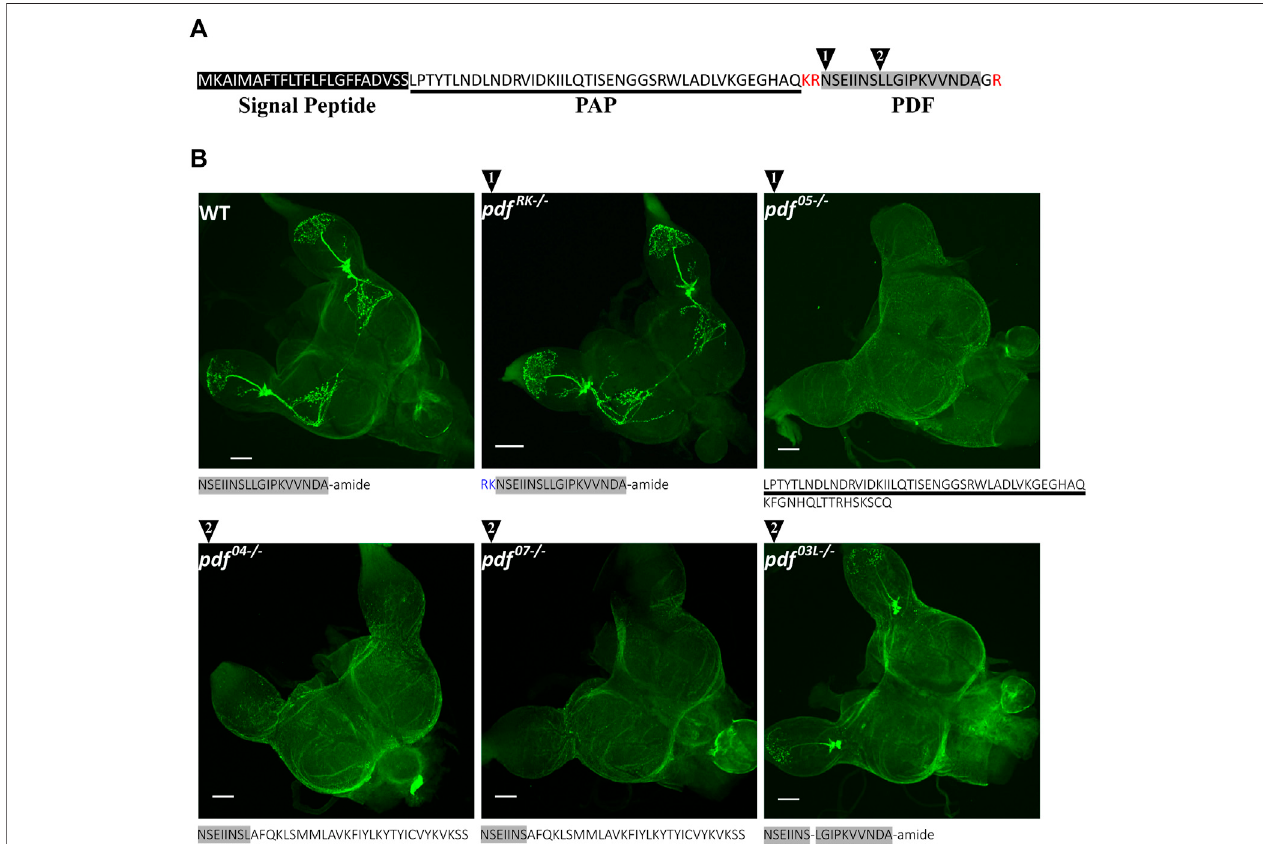
FIGURE 2 | P. apterus PDF structure and CRISPR/Cas9 generated pdf mutants. (A) Peptide sequence of P. apterus PDF precursor consists of: signal peptide (black rectangle), PDF-associated peptide (PAP, underlined) and PDF active peptide (grey rectangle). PDF active peptide is fl anked by basic amino acids predicted as a prohormone convertase cut sites (in red) and the last glycine is predicted to be amidated. Black triangles mark the position of the CRISPR/Cas9 target cut sites. (B) AminoacidsequencesandPDF-immunostaininginWTand pdf mutants. GreyrectanglemarksequencesidenticaltotheoriginalactivePDFpeptide. Notethat pdf RK − / − mutant has an identical staining pattern to WT, whereas pdf 04 − / − , pdf 05 − / − , and pdf 07 − / − mutants result in no PDF immunoreactivity. In-frame deletion in pdf 03L − / − removes conserved Leucine 8 and produces altered staining pattern without Dp arborizations and extrusions to the Me. PDF-immunostaining intensity in La is weaker compared to WT.